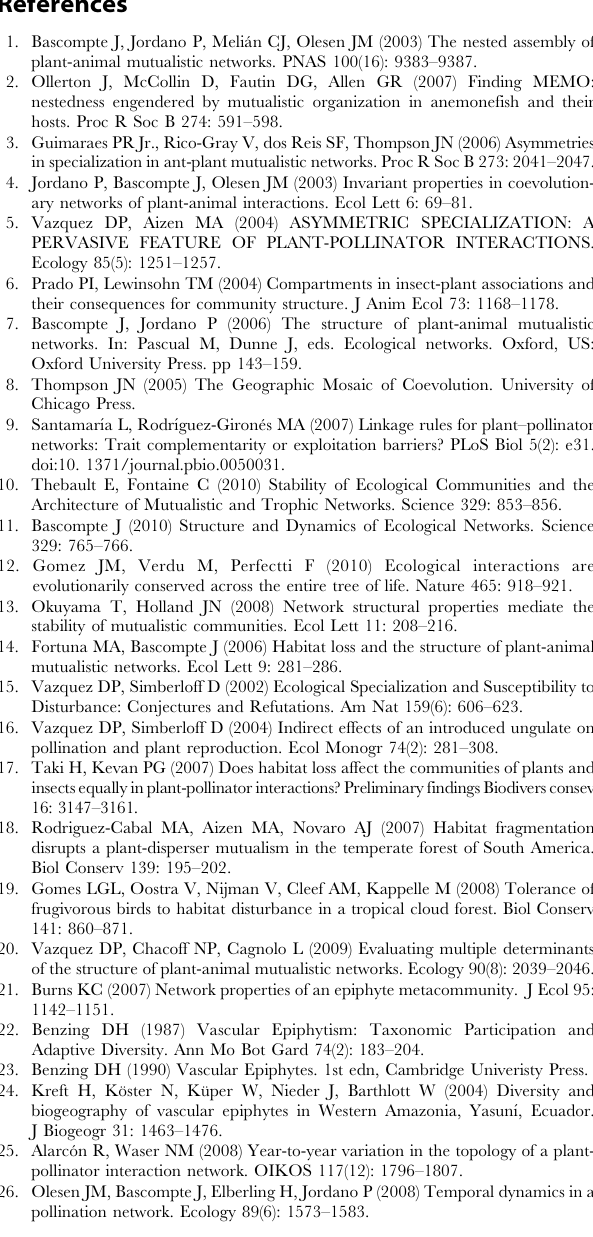
Figure S2 Nestedness of comensalistic, mutualistic and antagonistic networks. Nestedness is estimated using two different parameters: Atmar & Paterson’s N [38] and Almeida- Neto’s NODF [40]. Insets shows the differences in nestedness between antagonistic, comensalistic and mutualistic networks (after correction for the effect of network size: therefore ‘‘residual N’’ and ‘‘residual NOFD’’). Table S1 Details on the calculation of used indexes. Table S2 Data sources for all networks included in the analyses. Most of them are available at the NCEAS database (http://www.nceas.ucsb.edu/interactionweb/resources.html).